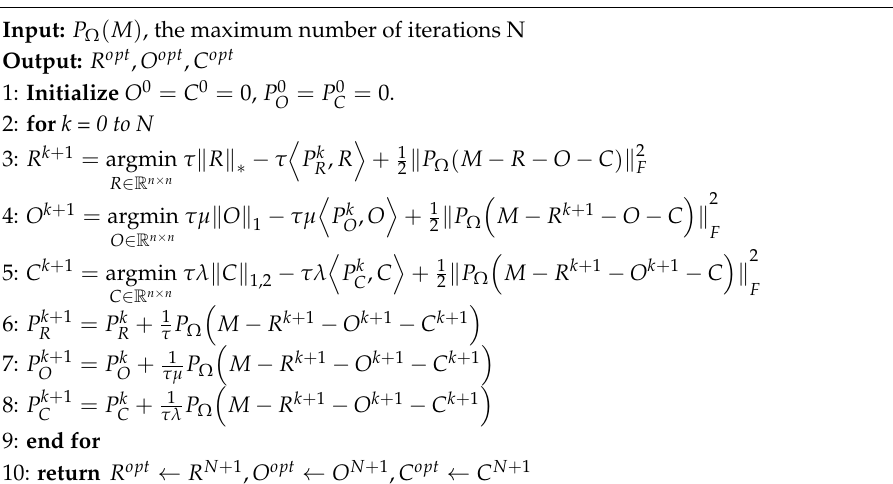
Algorithm 1 Algorithmic description of the